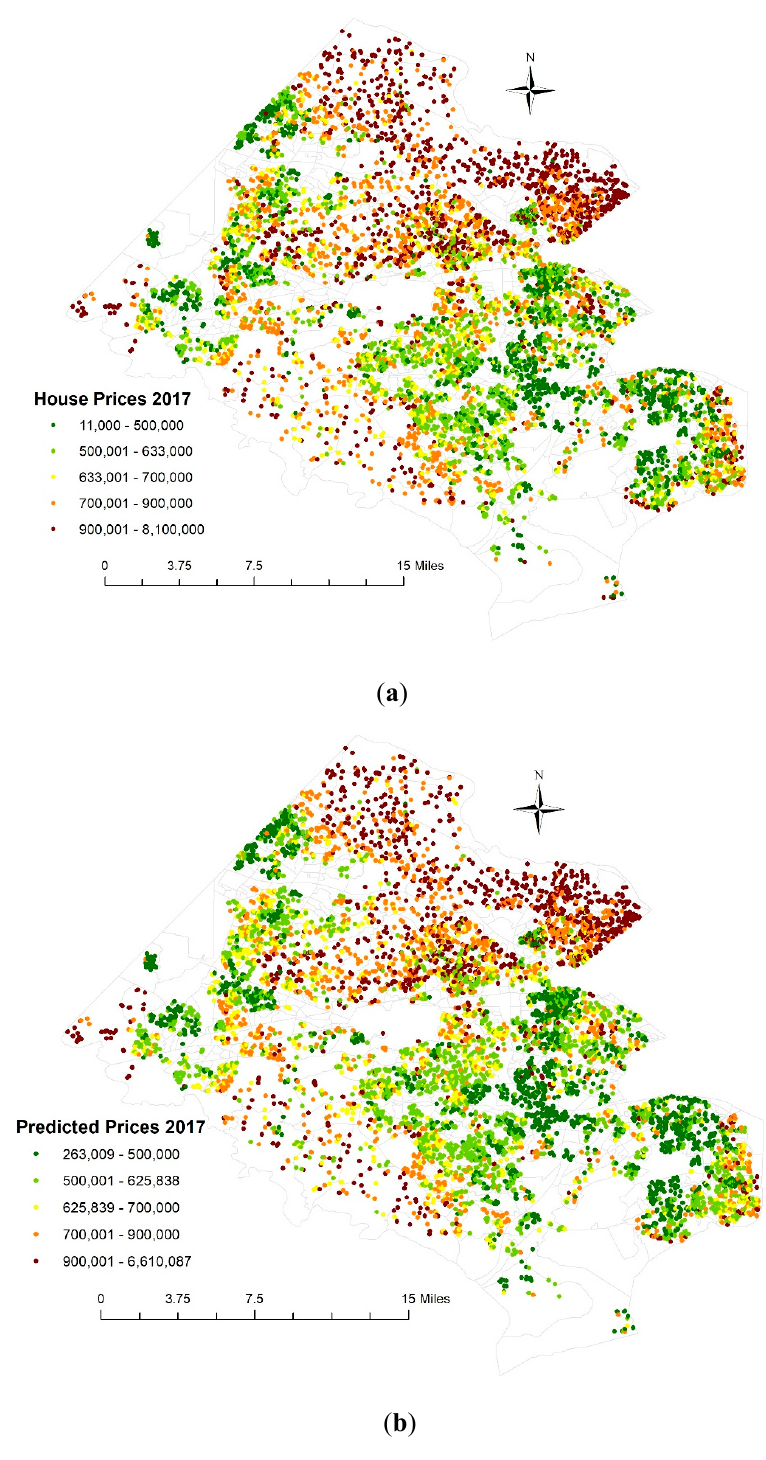
Figure 5. The geographic distributions of observed house prices ( a ) and predicted house prices ( b ) in 2017.